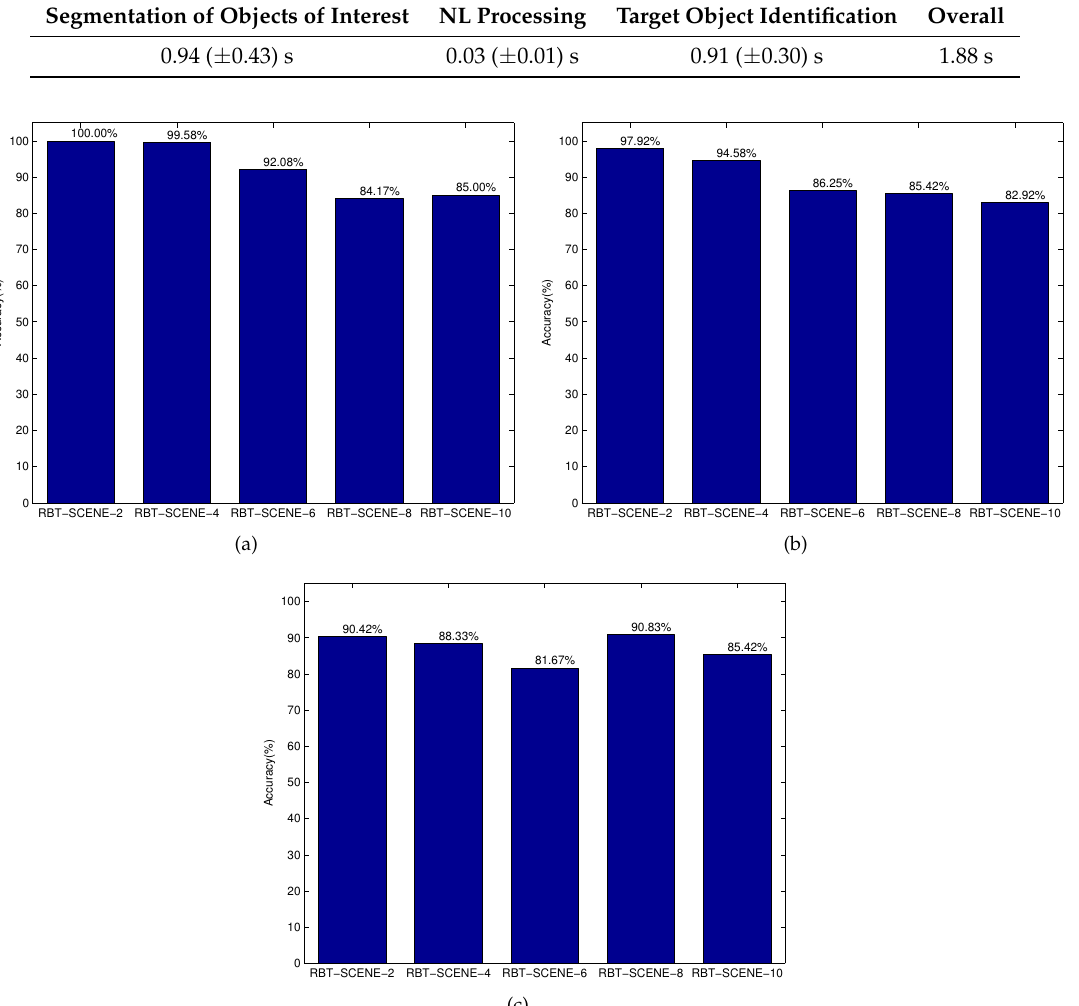
Table 5. Running time of the proposed method.